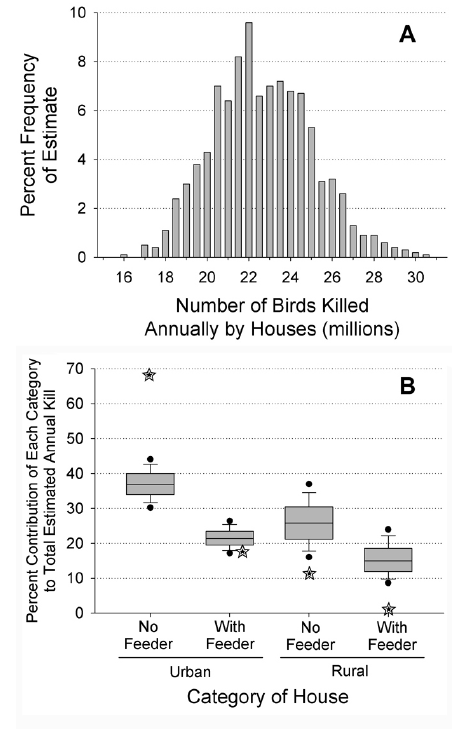
Fig. 4 . Estimates of bird mortality in Canada caused by collisions with windows in houses. Panel A shows results as a frequency distribution from all iterations (see Methods). Estimates were rounded to the nearest 0.5 million for graphing. Panel B is a box and whisker plot showing percent of the total annual mortality contributed by urban and rural houses with and without bird feeders. The stars above or below each box correspond to the percentage of the total buildings represented by that class (68%, 17%, 12%, and 3%). Lines in the boxes are medians, the 25th and 75th percentiles are the box boundaries, the 10th and 90th percentiles are the whiskers, and the solid dots are the upper and lower 5th